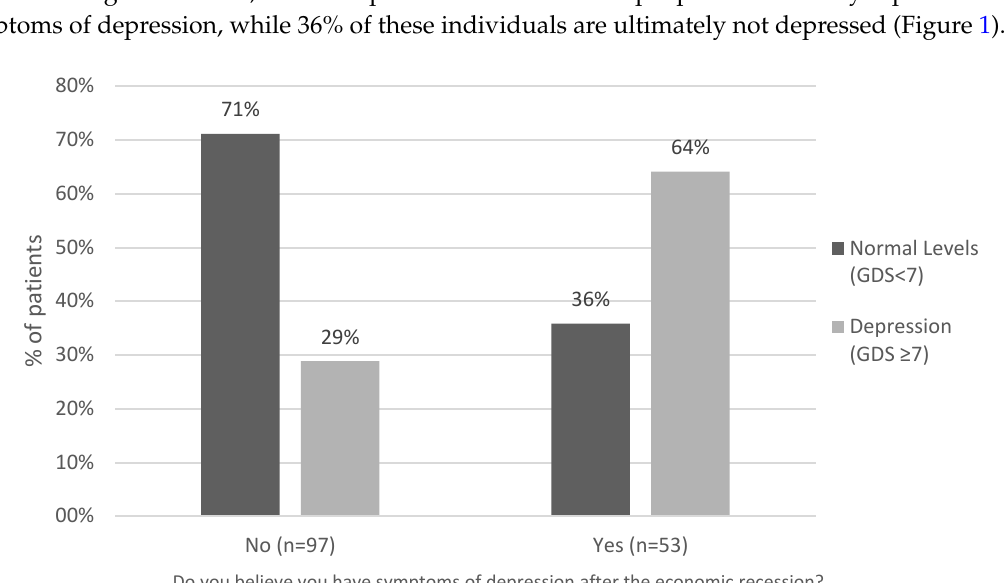
Figure 1. Self-reported depression symptoms vs. depression according to the GDS Scale (≥7).